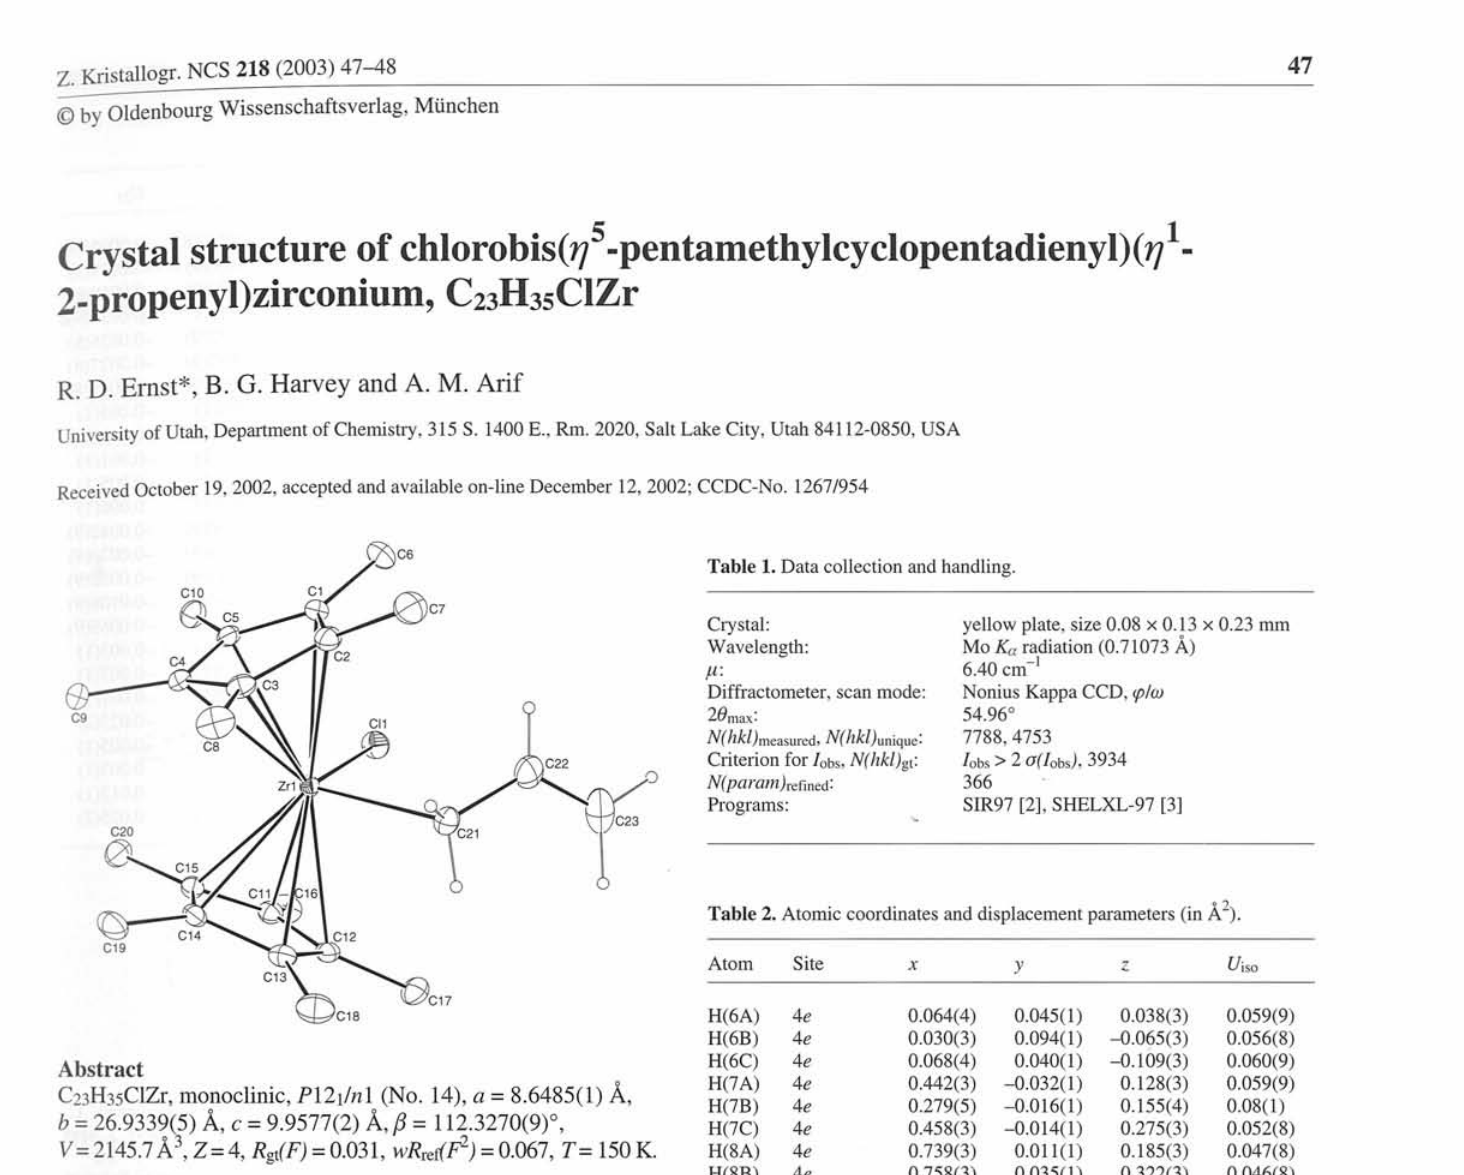
Table 2. Atomic coordinates and displacement parameters (in